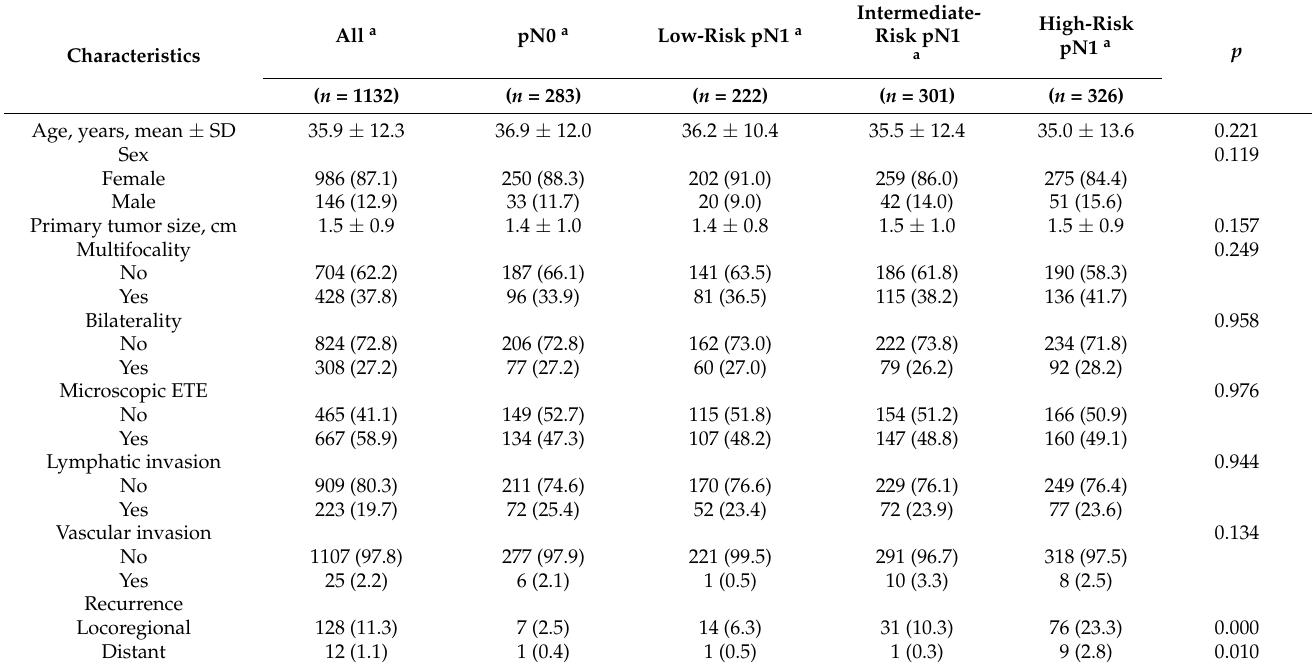
Table 5. Comparison of demographic characteristics between pathologic N0 and N1 patients after 1:3 propensity score